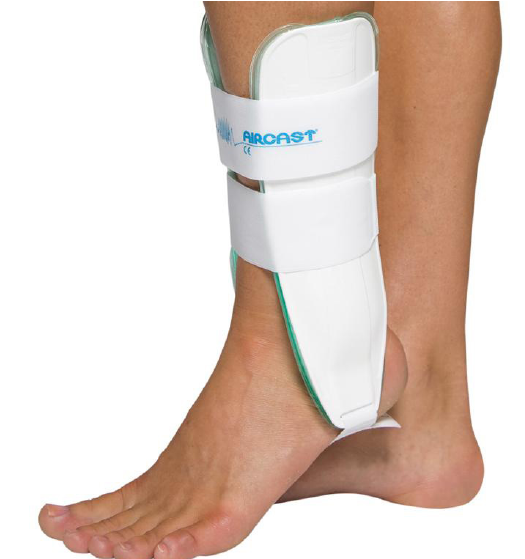
Figure 3. Semi-rigid brace used for ankle stabilization (Aircast Air